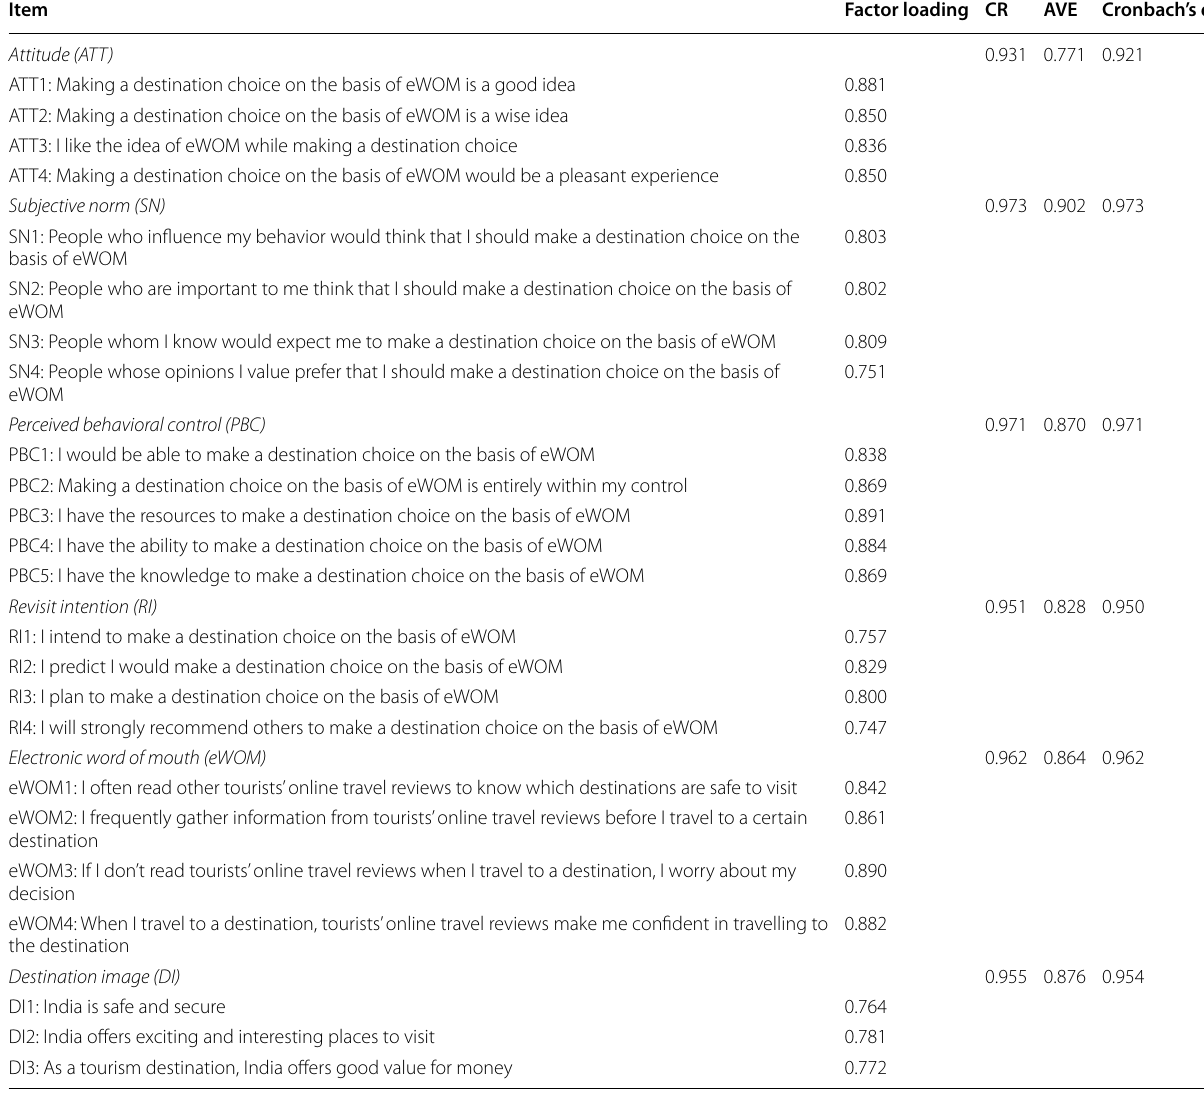
Table 4 Confirmatory factor analysis statistics. Source : Primary Data